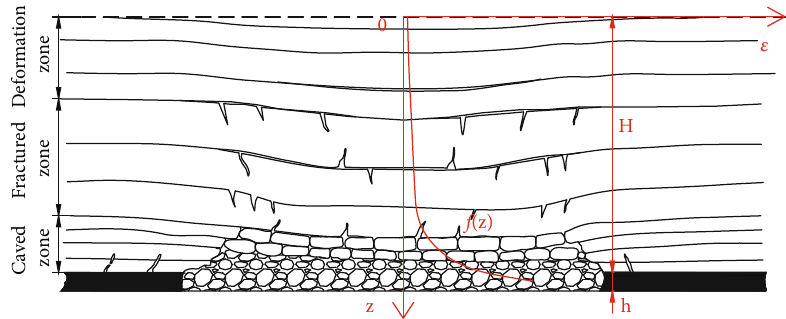
Figure 1: Distribution of “ Three Zones ” [26] and expansion distribution above the longwall